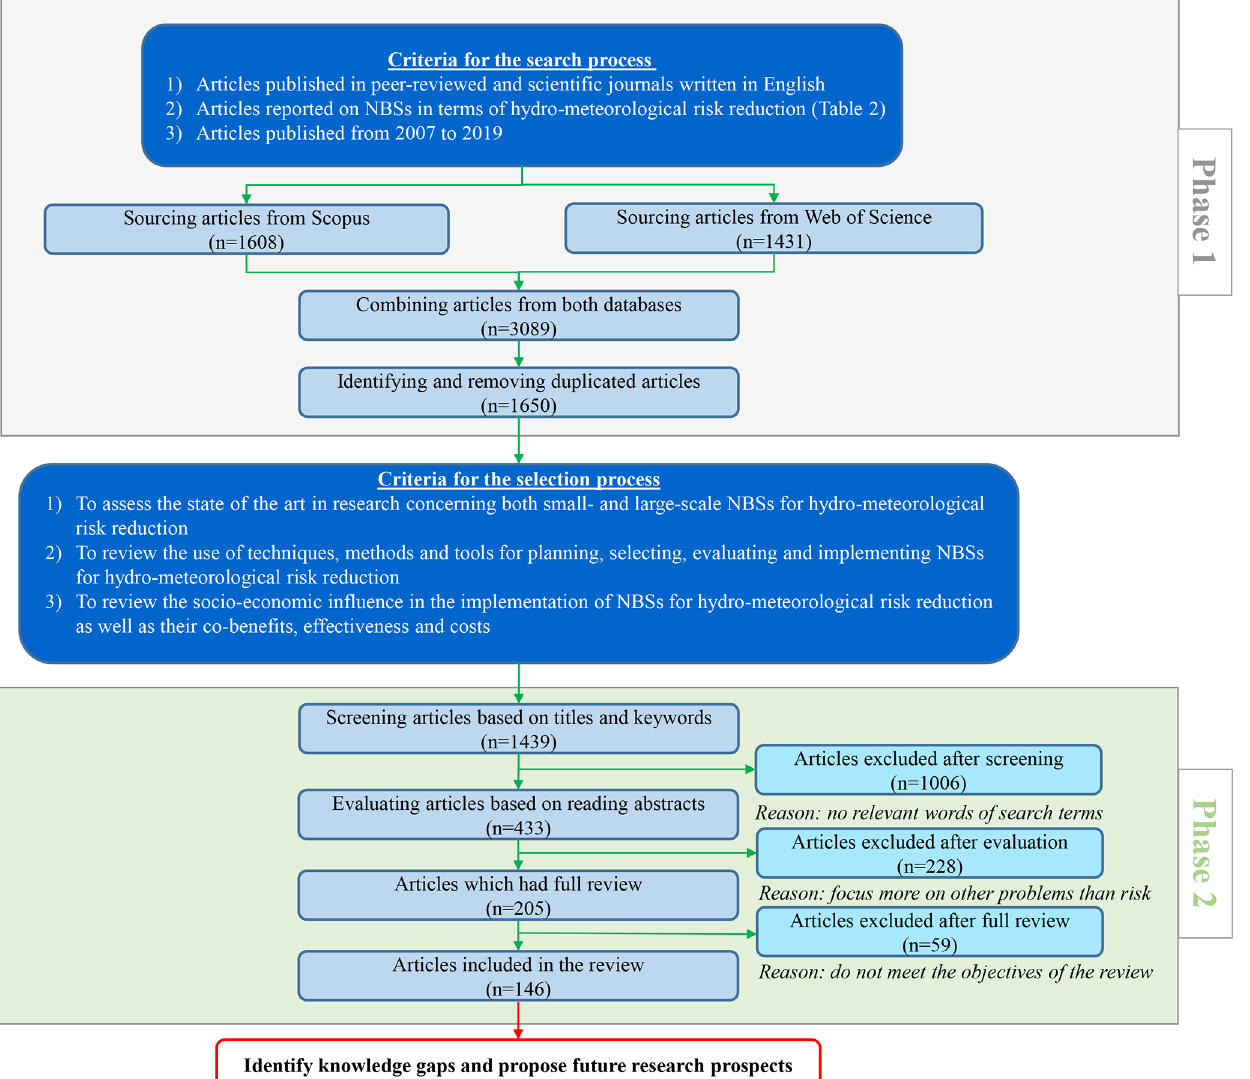
Figure 2. Process of article selection with systematic review method on nature-based solutions for hydro-meteorological risk reduction. The final number of fully reviewed articles is